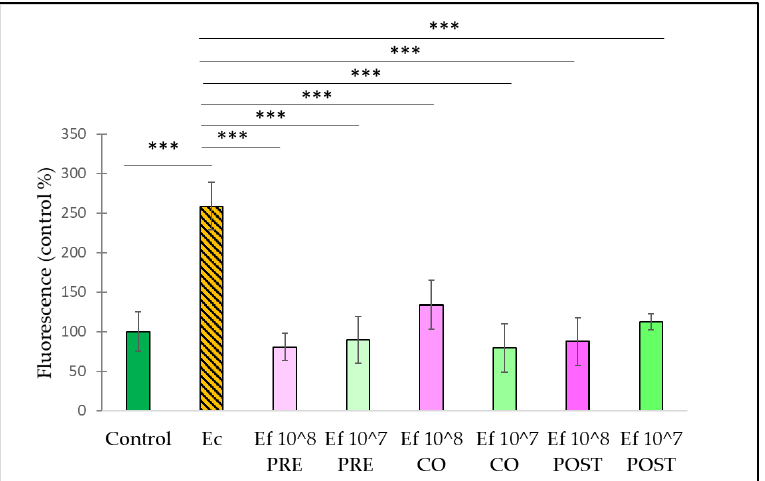
Figure 11. Effect of E. faecium on the paracellular permeability of IPEC-J2 cells treated with E. coli . E. faecium was added 1 h before (pre-treatment), at the same time (co-treatment) and 1 h after (post- treatment) the addition of E. coli . Detection of the FD4 dye was performed 24 after the treatment of E. coli . Control : plain cell culture medium treatment; Ec : E. coli 10 6 CFU/mL ; Ef 10^8 PRE : pre-treat- ment with E. faecium 10 8 CFU/mL + E. coli 10 6 CFU/mL; Ef 10^7 PRE : pre-treatment with E. faecium 10 7 CFU/mL + E. coli 10 6 CFU/mL; Ef 10^8 CO : co-treatment with E. faecium 10 8 CFU/mL + E. coli 10 6 CFU/mL; Ef 10^7 CO : co-treatment with E. faecium 10 7 CFU/mL + E. coli 10 6 CFU/mL; Ef 10^8 POST : post-treatment with E. faecium 10 8 CFU/mL + E. coli 10 6 CFU/mL; Ef 10^7 POST : post-treatment with E. faecium 10 7 CFU/mL + E. coli 10 6 CFU/mL. Data are shown as means ± SEs of three independent experiments; *** p ≤ 0.0001 compared to treatment with E. coli .